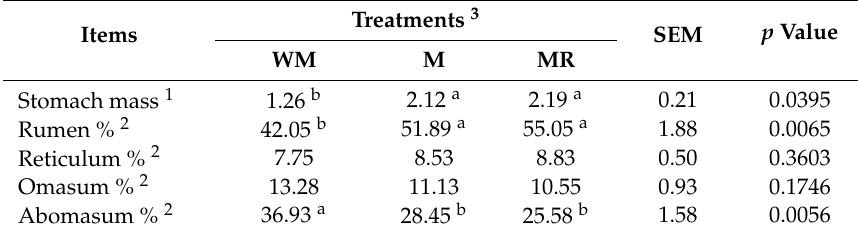
Table 6. Stomach development for two-month-old calves (male, n = 3 per each